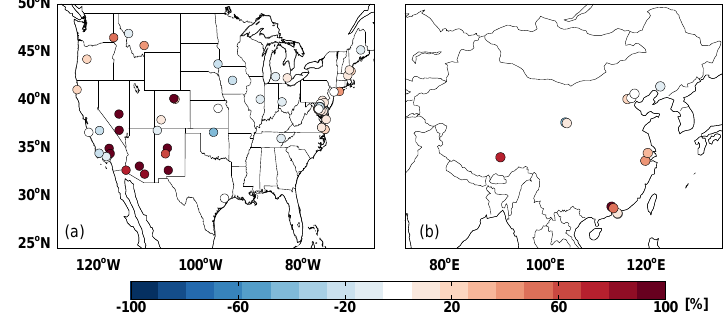
Figure 7. Normalized mean bias in AOD between MODIS-Aqua Collection 6 and AERONET sites for (a) the US and (b) China. Table 2. List of model sensitivity tests and descriptions with results shown in Fig.